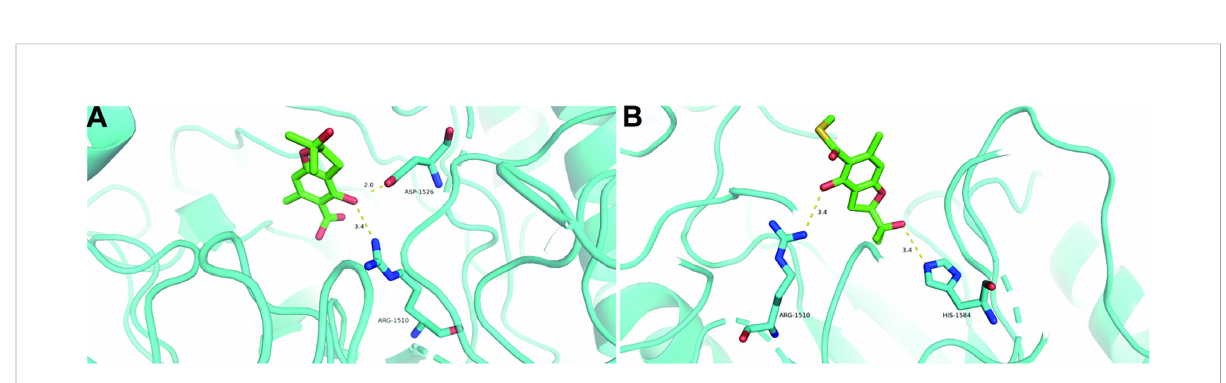
FIGURE 6 Docking poses and interactions of 3 (A) and 4 (B) with a -glucosidase (PDB ID: 3TOP). Hydrogen bond was denoted with yellow dash line.